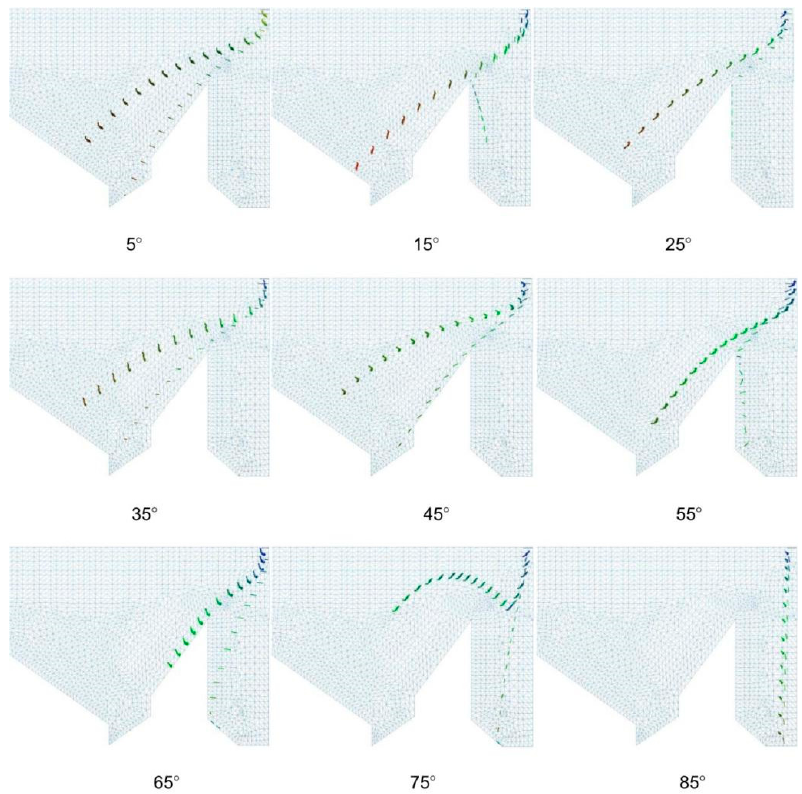
Figure 10. Leaf (upper trajectory) and stem (lower trajectory) drifts resulting from various wind direction angles.